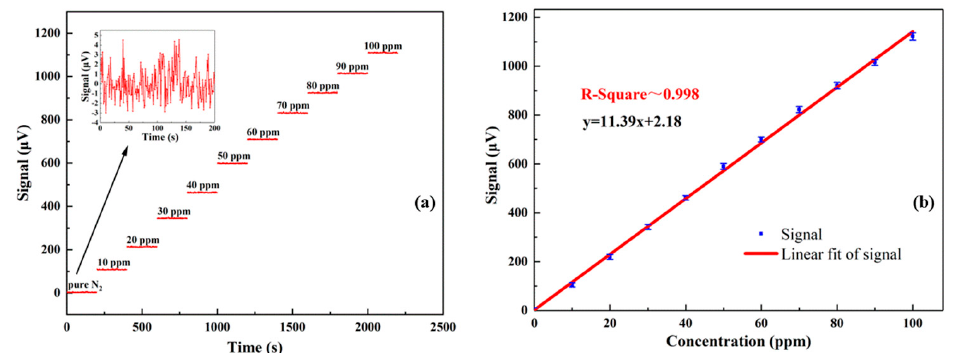
Figure 3. ( a ) 200 s-long measurement of the photoacoustic signal acquired for H 2 S gas concentrations from 0 to 100 ppm. Inset: photoacoustic signal acquired when pure nitrogen was flushed into the photoacoustic cell. ( b ) 200 s-averaged photoacoustic signals as a function of H 2 S concentration (blue data points) and linear fit (red solid line).